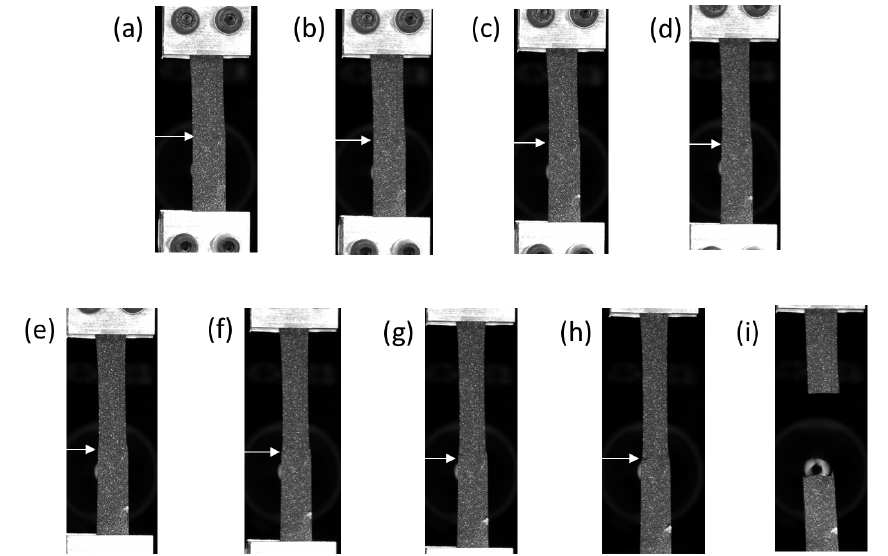
Figure 6. Pictures related to Figure 4, specimens overmoulded at 260 ◦ C . TPV1 is at the bottom and TPV2 at the top.